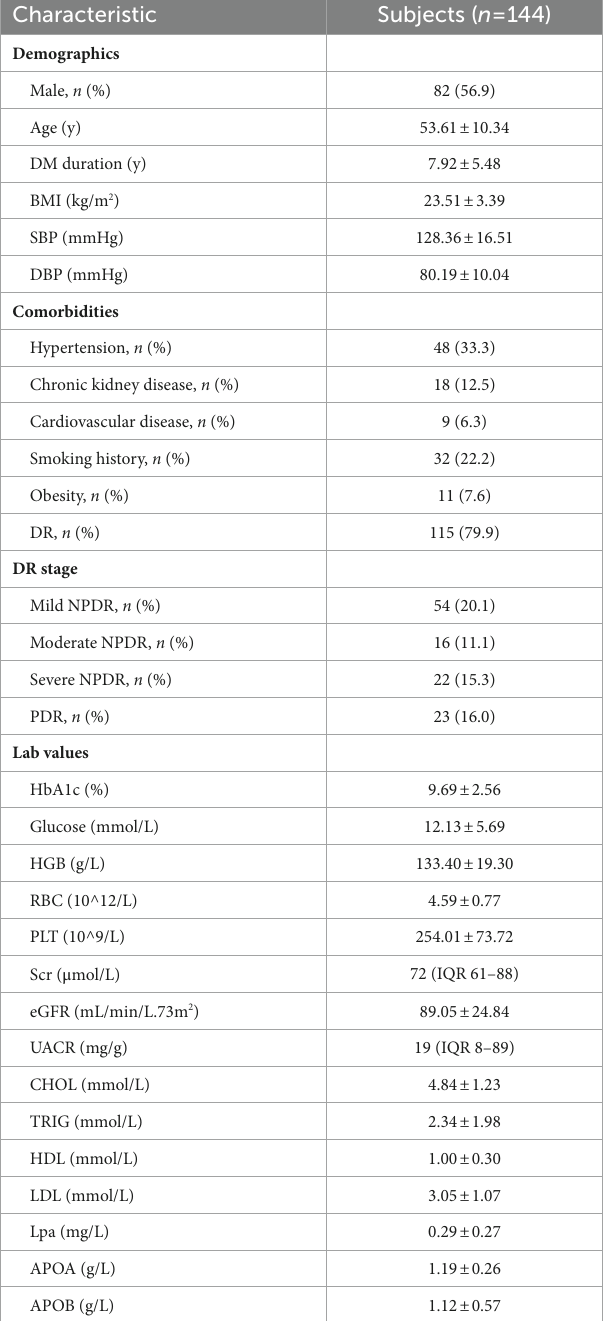
TABLE 1 Patient demographics and clinical characteristics. TABLE 2 Vessel density and perfusion density in superficial vascular